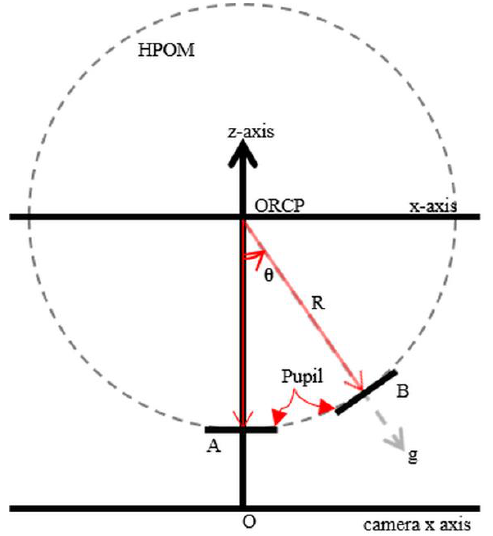
Figure 2. Ellipse change principle of the pupil shown in the cross section of the x-axis and z-axis coordinate system.